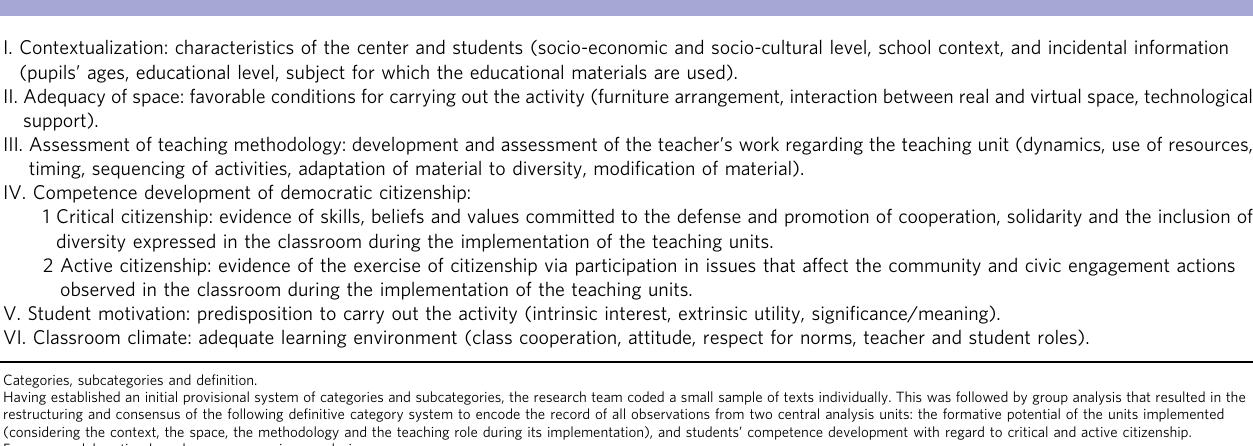
Table 2 System of agreed categories for observation analysis.